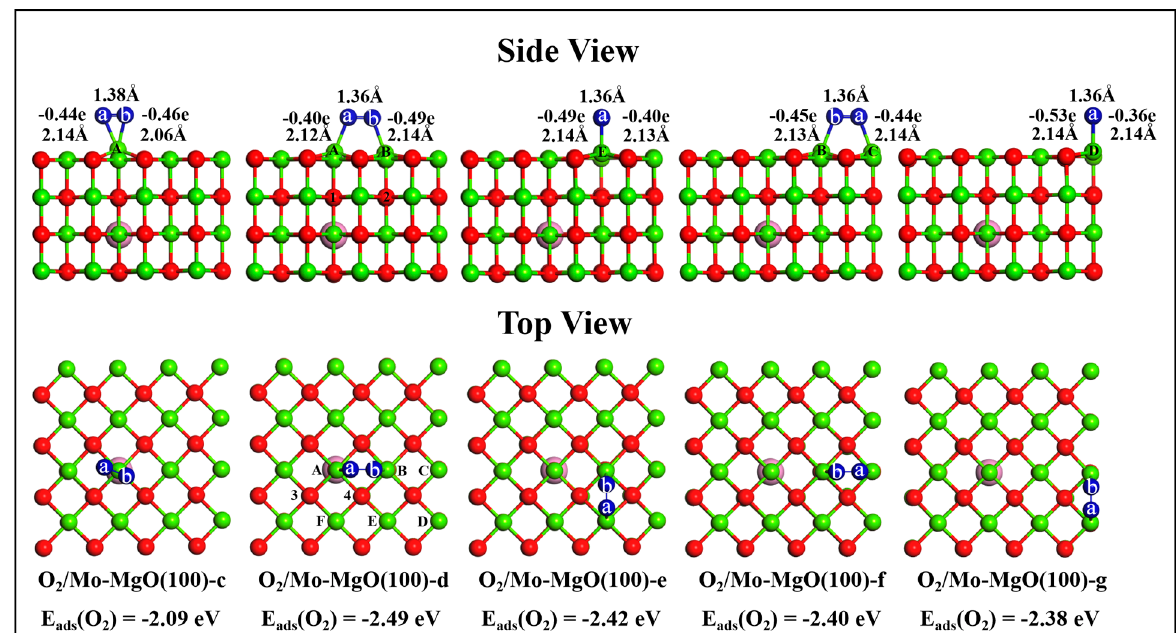
Figure 1. The optimized structure of oxygen molecule on Mo-doped MgO(100). The charge, bond distance, and adsorption energy are also included. Mg atom is in green and oxygen is in red while gas phase oxygen molecule is in blue.